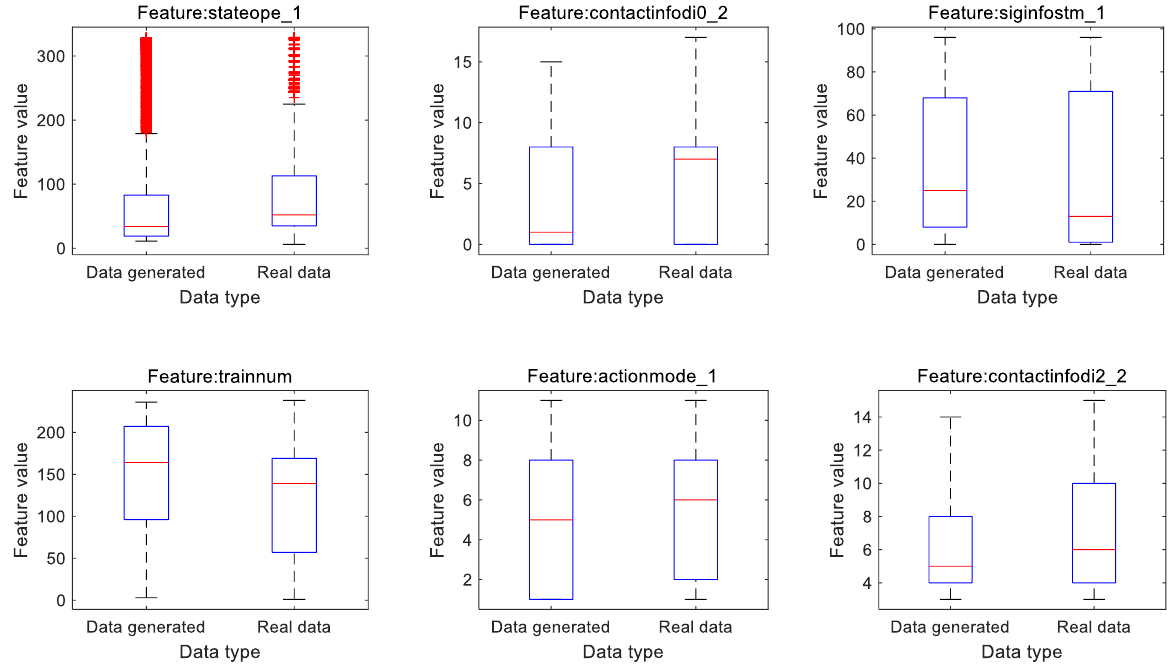
Figure 7. Comparison of the data distribution corresponding to six main features.